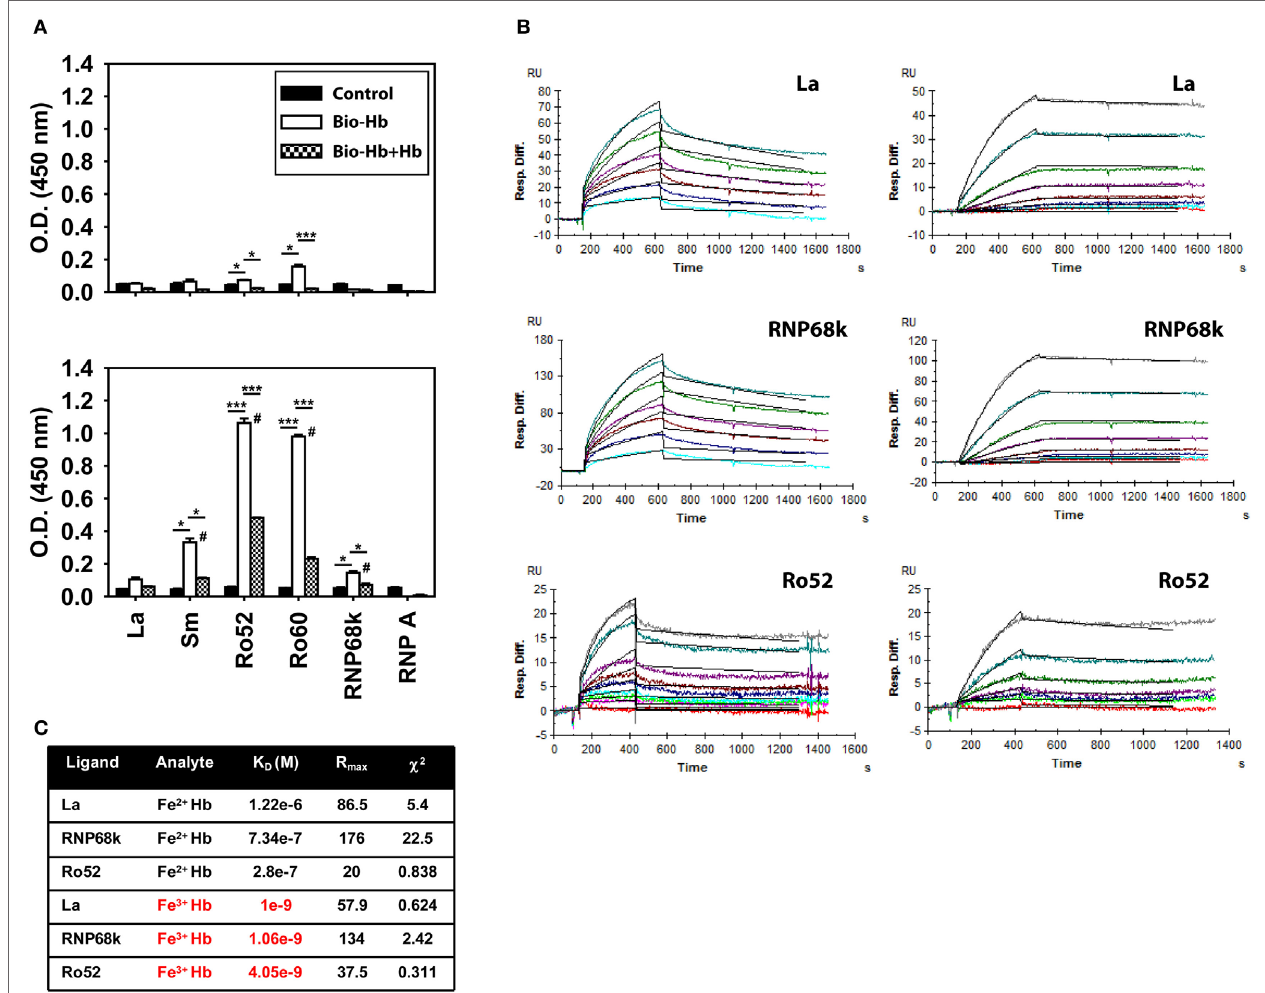
FigUre 4 | Interaction of hemoglobin (Hb) with autoantigens. (a) Interaction of biotinylated Fe 2 + Hb (Bio-Hb, top panel) and biotinylated Fe 3 + Hb (Bio-Hb, bottom panel) with the indicated autoantigens; the effects of the addition of unlabeled Hb are also shown. * p < 0.05; *** p < 0.001; # p < 0.05 vs Fe 2 + Hb at the corresponding concentration. (B) Surface plasmon resonance analysis of the binding of Fe 2 + Hb (left panels) and Fe 3 + Hb (right panels) with immobilized autoantigens La, RNP68k, and Ro52, as indicated. Concentrations of Fe 2 + Hb employed to assess interaction with La and RNP68k were 0.5, 1, 2, 3, 5, and 7 µM (light blue to turquoise) and of Fe 3 + Hb were 0, 1.56, 3.12, 6.25, 12.5, 25, 50, and 100 nM (red to gray). Concentrations of Fe 2 + Hb employed to assess interaction with Ro52 were 0, 0.1, 0.2, 0.4, 0.8, 1.6, 3.2, 6.4, and 9.6 µM (red to gray) and of Fe 3 + Hb were 0, 0.78, 3.12, 6.25, 12.5, 25, and 50 nM (red to gray). Black lines alongside each profile indicate data-fitting using the 1:1 (Langmuir) Binding Model. (c) Parameters describing the kinetics of Hb-autoantigen interaction. Data are representative of three independent